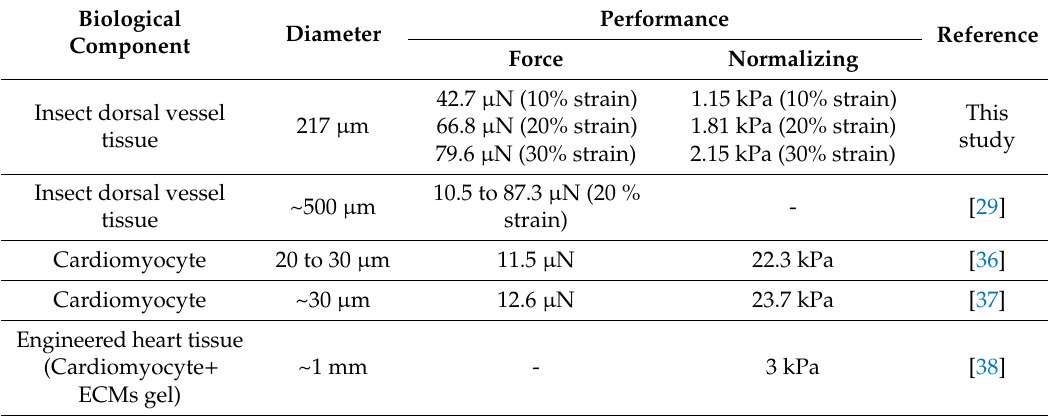
Table 1. Contractile performance of each type of biological